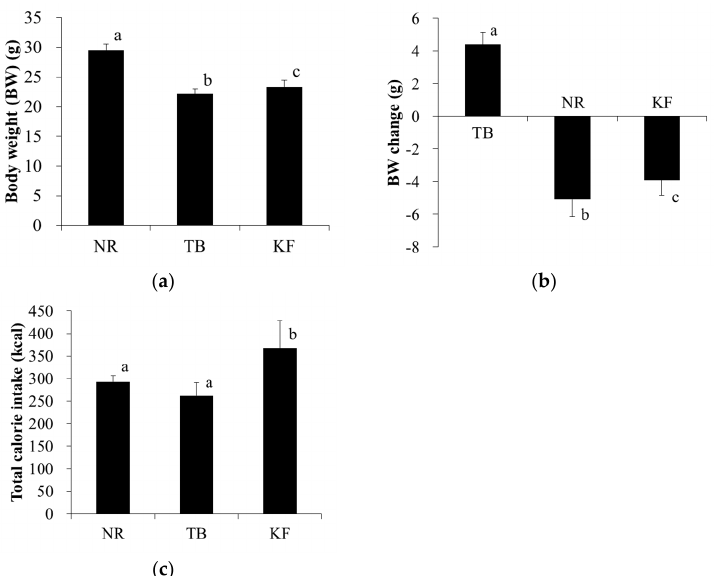
Figure 1. Effect of ketogenic formula on weight gain and total energy intake in mouse model of colorectal cancer. Legend: ( a ) Body weights and ( b ) body weight gain at the day of necropsy (day 21 after tumor inoculation); and ( c ) total energy intake. Values are means ± standard deviations, and values with different superscripts are significantly different ( p < 0.05). NR, normal group; TB, tumor-bearing group; KF, ketogenic formula group.